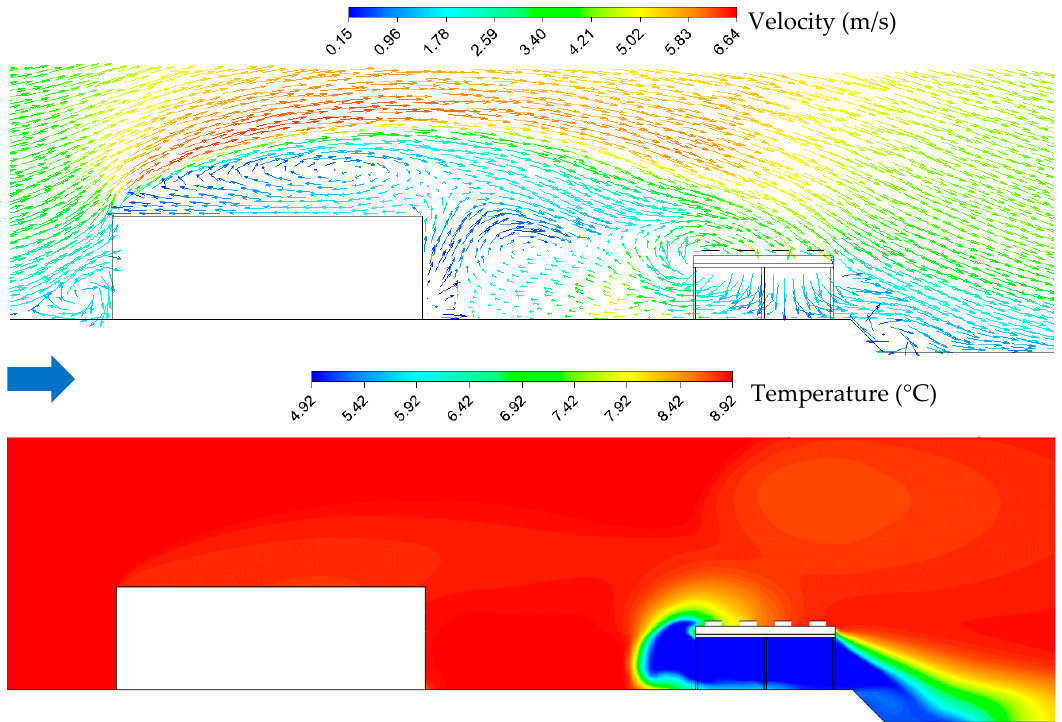
Figure 18. Velocity streamlines and temperature contour at row 17, real field and west wind condition.